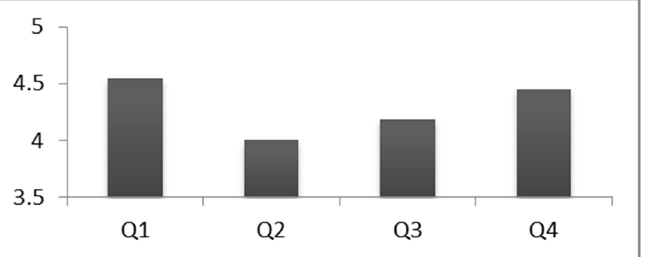
Figure 25. Average ratings of participants for the sixth set of questions concerning the perceived performance of the proposed app.